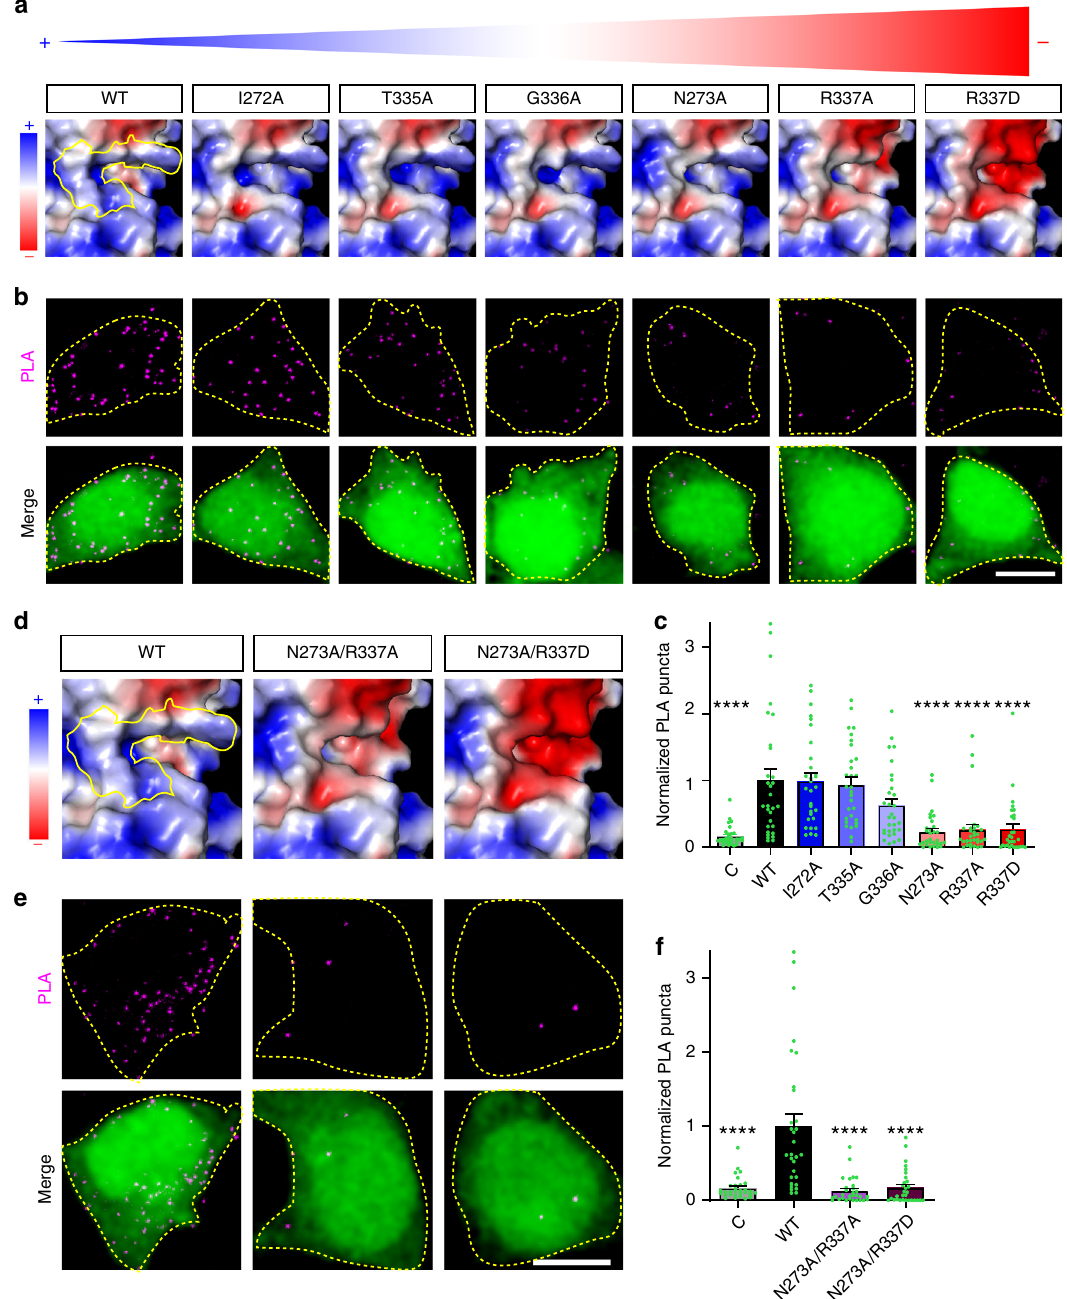
Fig. 5 Speci fi c hinge region amino acid residues are responsible for the EphB2 – GluN1 interaction in HEK293T cells. a Surface charge maps of GluN1 NTD hinge region of the indicated GluN1 single point mutants in order of increasing negative charged in the hinge region (left (positive) to right (negative)), with blue representing positive charge and red representing negative charge. Yellow outline indicates the location of the six key hinge region amino acids in WT GluN1. b Representative images of PLA results in HEK293T cells. HEK293T cells were transfected with the indicated Myc-GluN1 single point mutants, together with GluN2B, FLAG-EphB2, and EGFP. The upper panels show PLA signal alone. The lower panels are merged images of EGFP in green and PLA signal in magenta. Scale bar = 10 µ m. c Quanti fi cation of the effects of GluN1 mutants on PLA puncta number. PLA puncta number are quanti fi ed by counting the number of puncta per 100 µ m 2 in EGFP + cells and normalizing to the WT condition (**** p < 0.0001, ANOVA; green dots represent n = 30 cells for each condition). d Surface charge maps of GluN1 NTD hinge region of the indicated GluN1 double point mutants as in a (left (positive) to right (negative)). Yellow outline indicates the location of the six key hinge region amino acids in WT GluN1. e Representative images of PLA results in HEK293T cells. HEK293T cells were transfected with the indicated Myc-GluN1 double point mutants, together with GluN2B, FLAG-EphB2, and EGFP. The upper panels show PLA signal alone. The lower panels are merged images of EGFP in green and PLA signal in magenta. Scale bar = 10 µ m. f Quanti fi cation of the effects of GluN1 mutants on PLA puncta number. PLA puncta number are quanti fi ed by counting the number of puncta per 100 µ m 2 in EGFP + cells and normalizing to the WT condition (**** p < 0.0001, ANOVA; green dots represent n = 30 cells for each